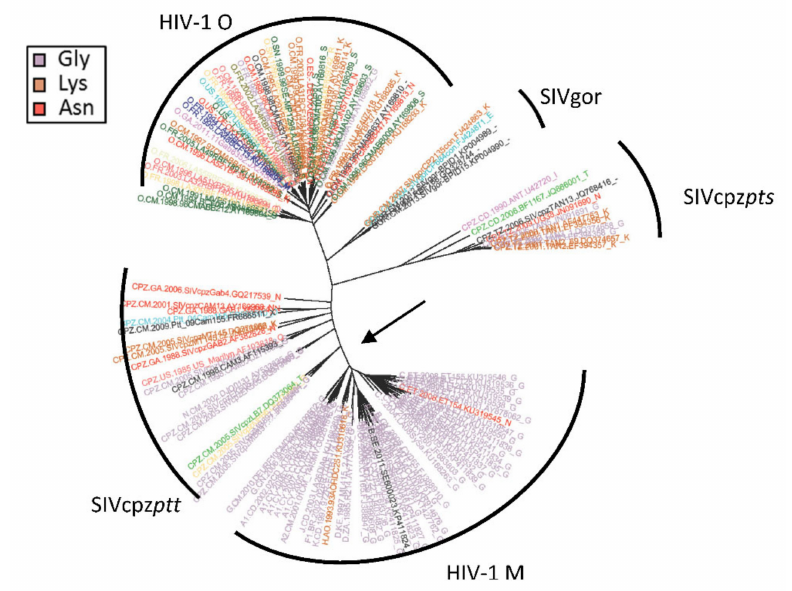
Figure 1. Projection of Env 458 on the HIV-1 / SIV phylogeny. Each leaf (corresponding to an HIV / SIV strain) is color-coded based on the amino acid present at Env 458 . The legend shows the three most prevalent amino acids found at this site. The substitution rate of Env 458 , which interacts with the CD4 receptor, was found to be slower in HIV-1 group M than in the rest of the phylogeny, with the branch separating both clades marked by an